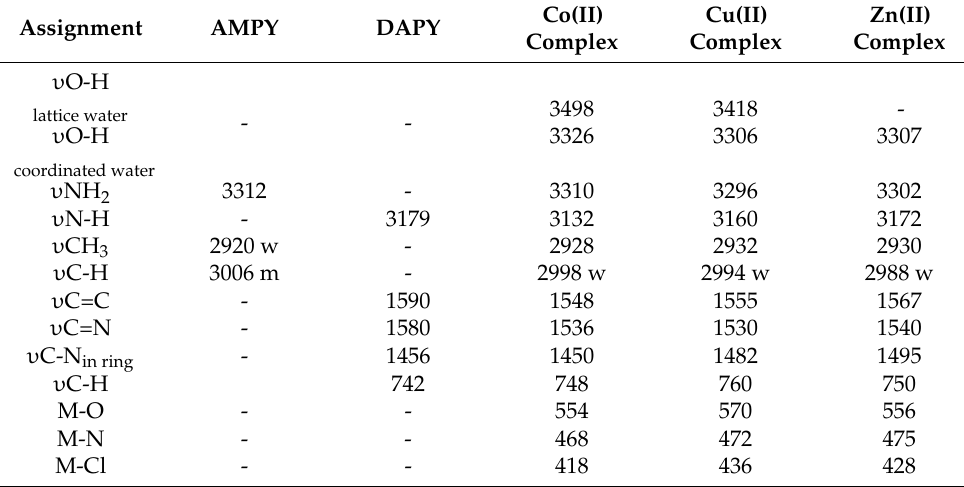
Table 1. The infrared spectral data (cm − 1 ) of the ligands and their complexes.